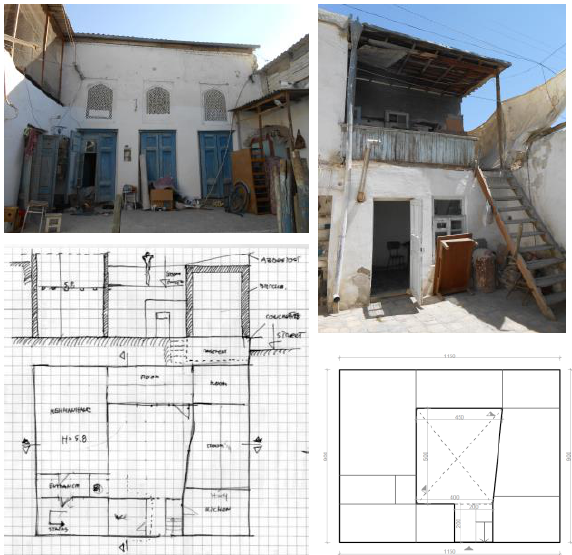
Figure 12. Field notes and floor plan in AutoCAD. Survey of